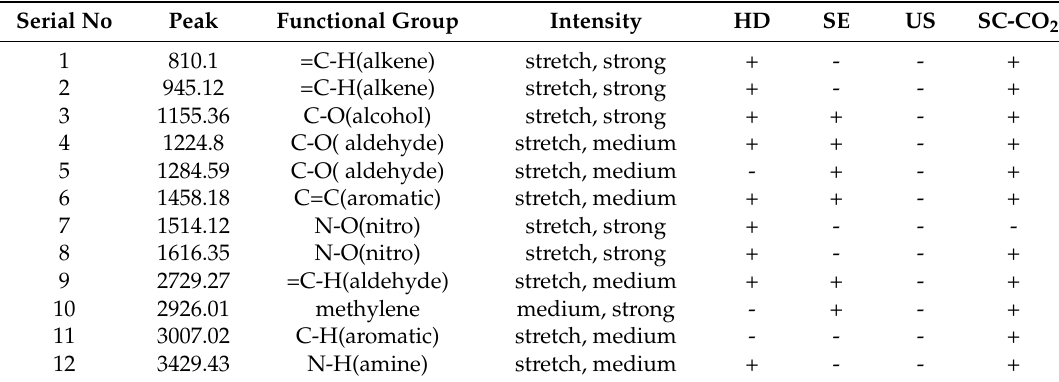
Table 6. Results of the FTIR analysis of T. ammi oil extracted by different techniques. Serial No